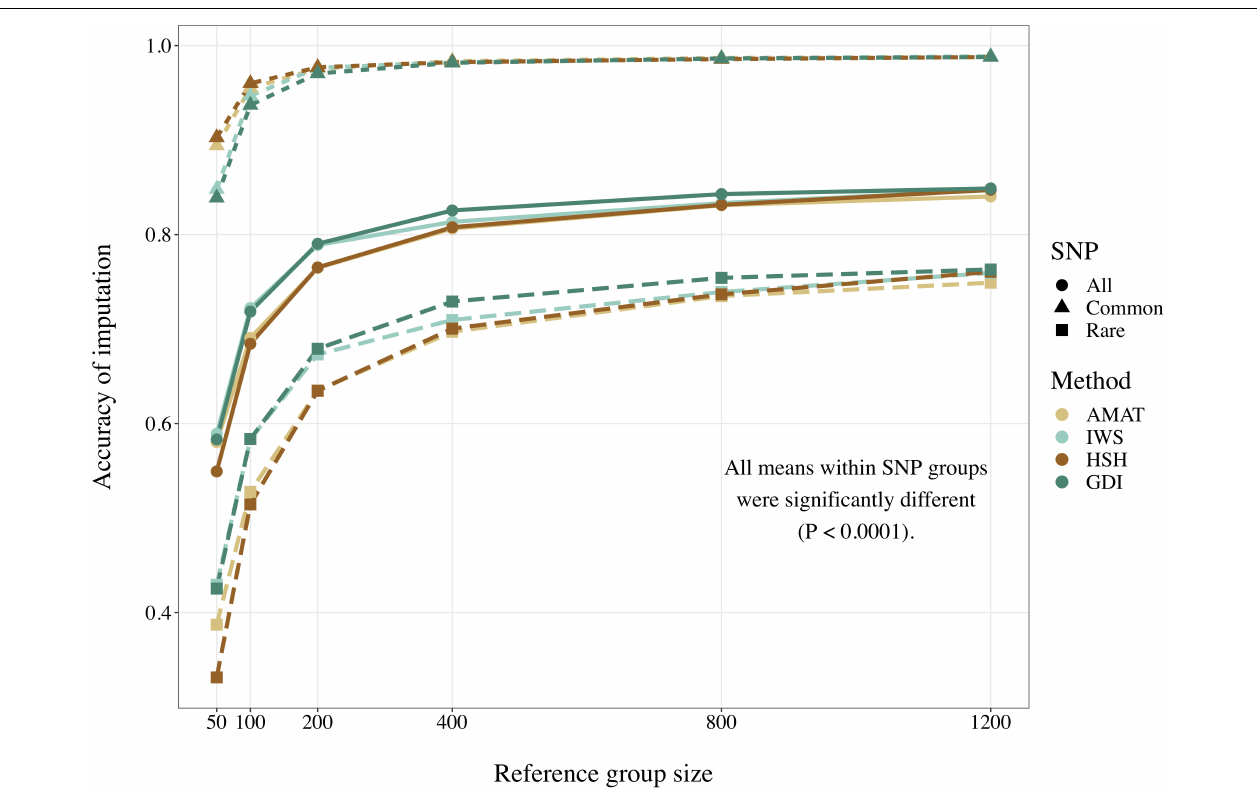
FIGURE 9 | Accuracy of imputation for all SNP, only common SNP (minor allele frequency ≥ 0.05), or only rare SNP (minor allele frequency < 0.05), using reference population sizes from 50 to 1,200 individuals. The methods compared are the key ancestors (AMAT), the Highly Segregating Haplotype selection (HSH), the Inverse Weighted Selection (IWS), and the Genetic Diversity Index (GDI). All standard errors are below 0.013.